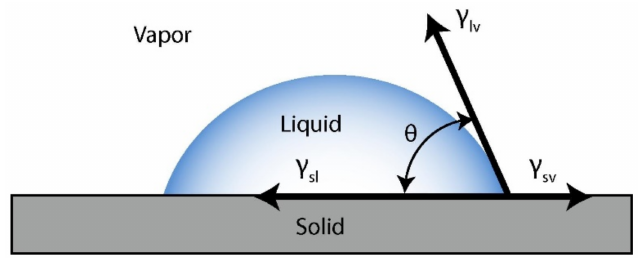
Figure 1. Simplified representation of contact angle